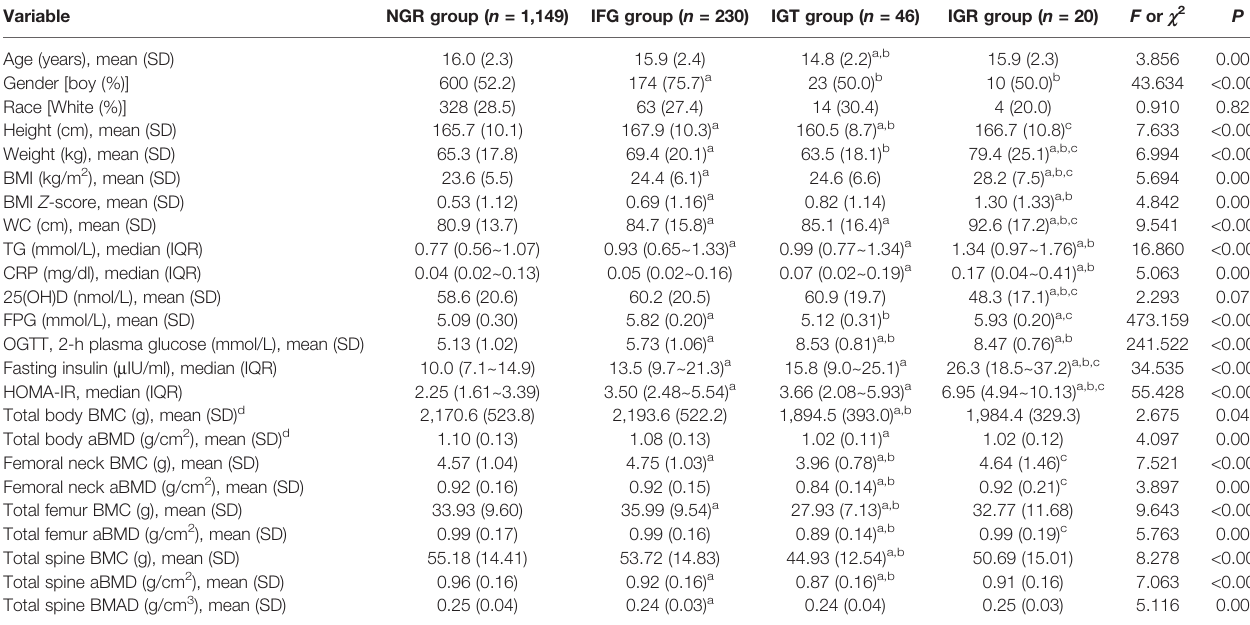
TABLE 1 | Clinical and laboratory characteristics of the subjects in each group. Variable